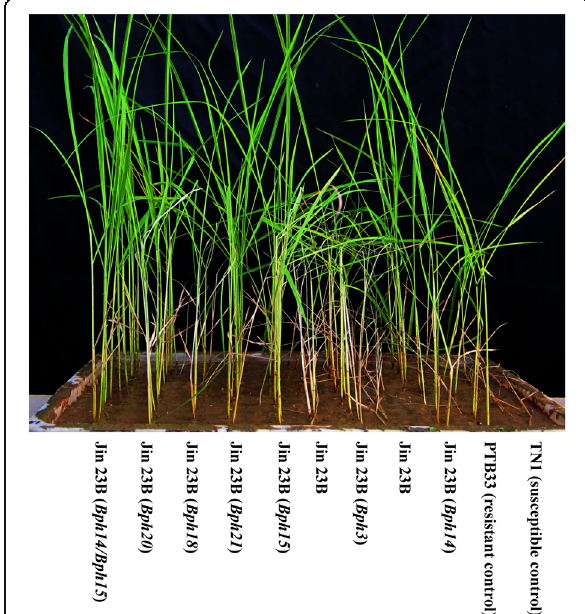
Fig. 4 Photograph of resistance level to BPH of improved Jin 23B with resistance gene Bph3 , Bph14 , Bph15 , Bph18 , Bph20 , Bph21 and Bph14 / Bph15 at the seedling stage (the 7 days after infested with BPH). PTB33 (carrying Bph3 ) is a resistance control and TN1 is a susceptible